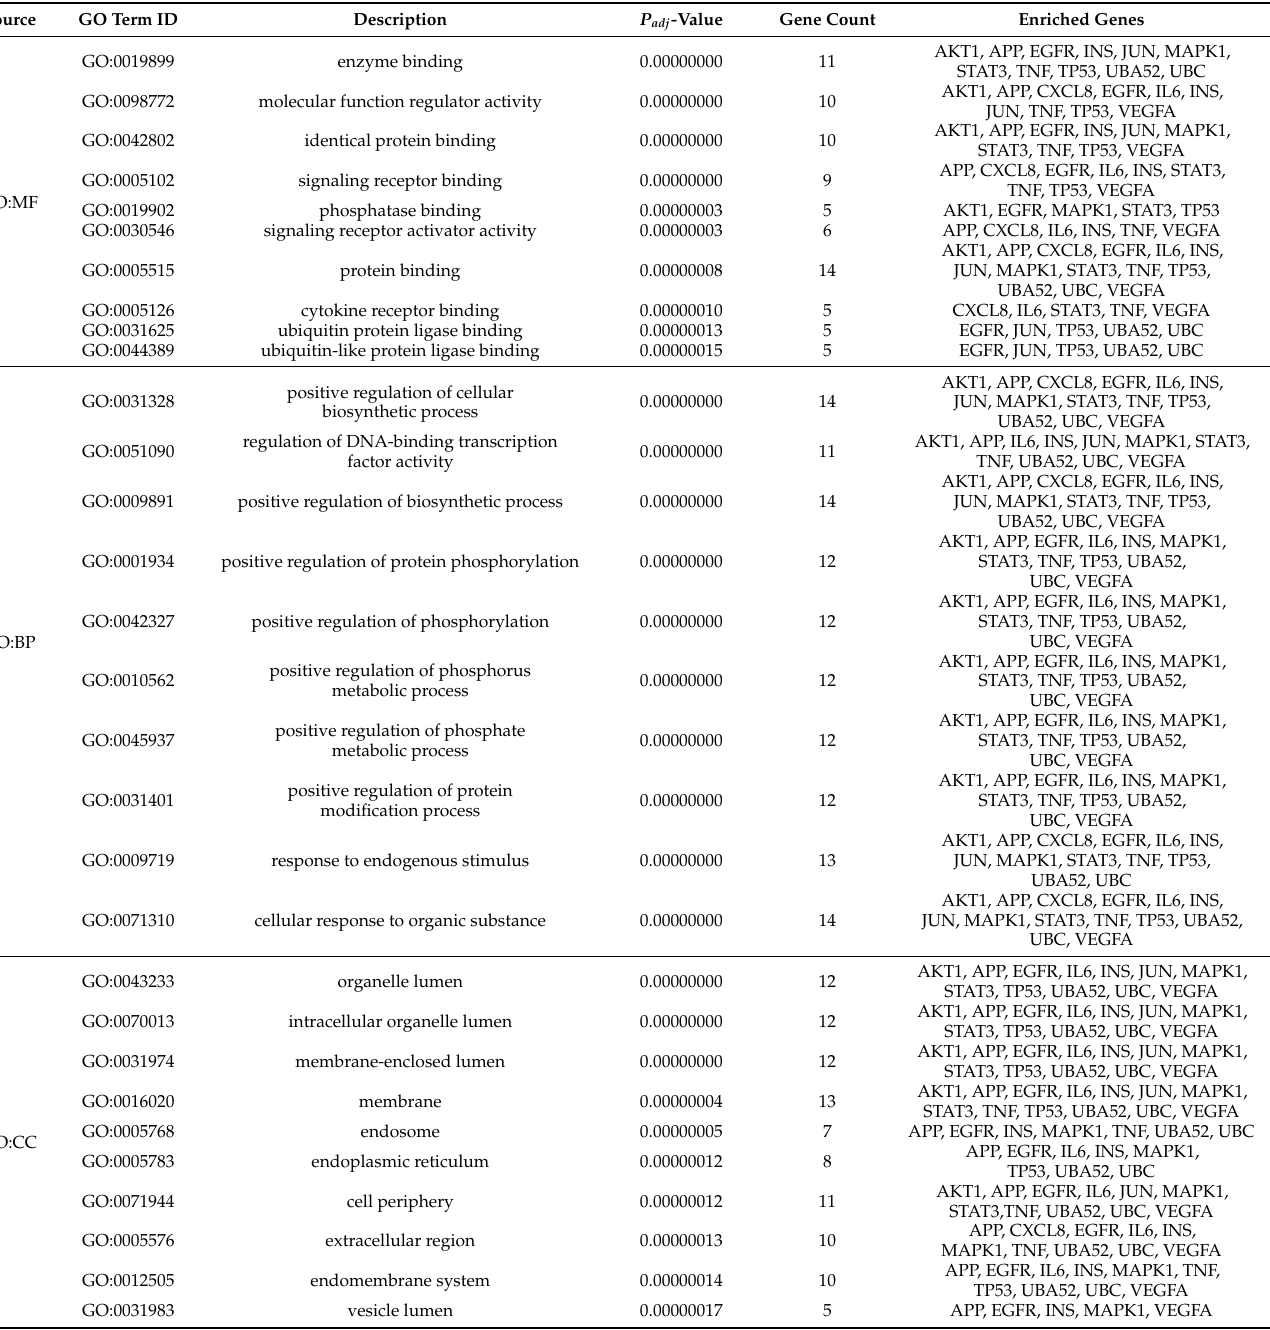
Table 2. The top 10 significantly enriched GO terms for each of BPs, MFs, and CCs based on the hHub-DEGs-set enrichment analysis, where hHub-DEGs-set consisted of 14